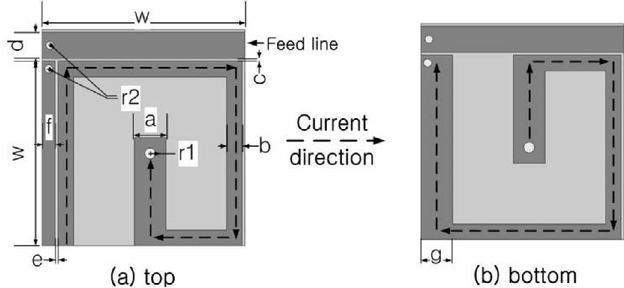
Fig. 5. Geometry and surface current direction for MZR antenna with the same current path ( a = 1.2mm, b =0.6 mm, c =0.1 mm,